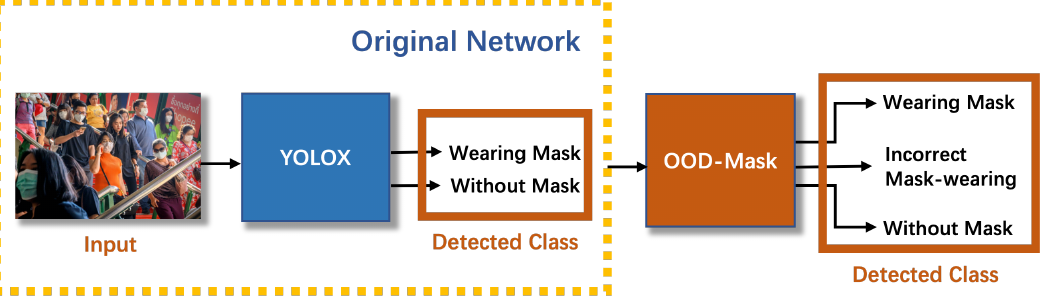
Figure 6. Network Architecture: The YOLOX network is trained with two-class training dataset and performs two-class detection. The prediction output of YOLOX is then passed through the OOD-Mask to obtain three-class detection